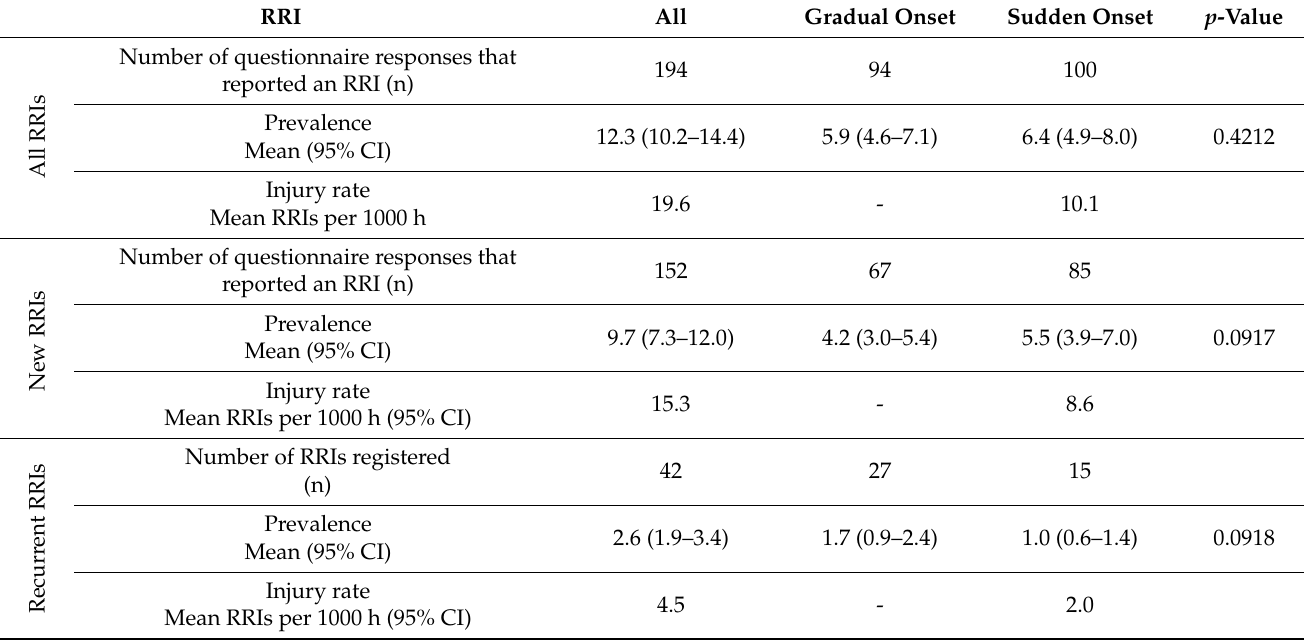
Table 3. (1) Total number (n) of questionnaire responses that reported an RRI (gradual and sudden onset, and new and recurring), (2) prevalence (%), and (3) injury rate (RRIs per 1000 h). RRI